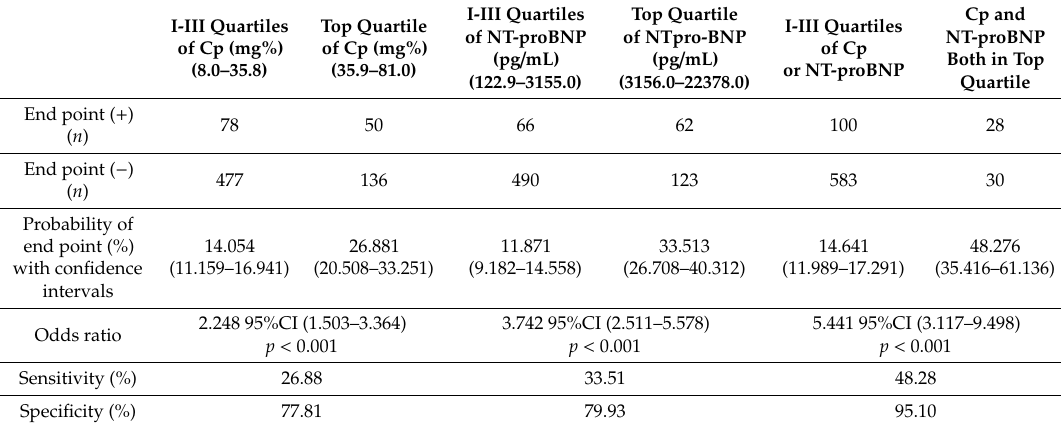
Table 4. Probability of death or heart transplantation occurrence in 1-year